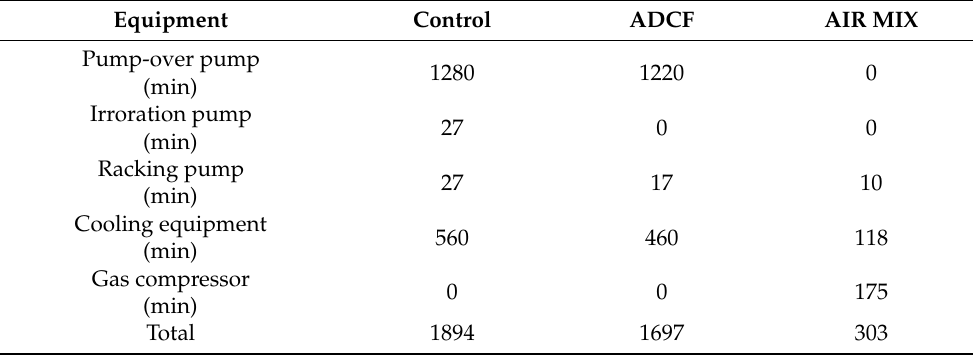
Table 4. Labor-time (min) of each vinification method compared to each vinification techniques. Data refer to the mean of the two-year